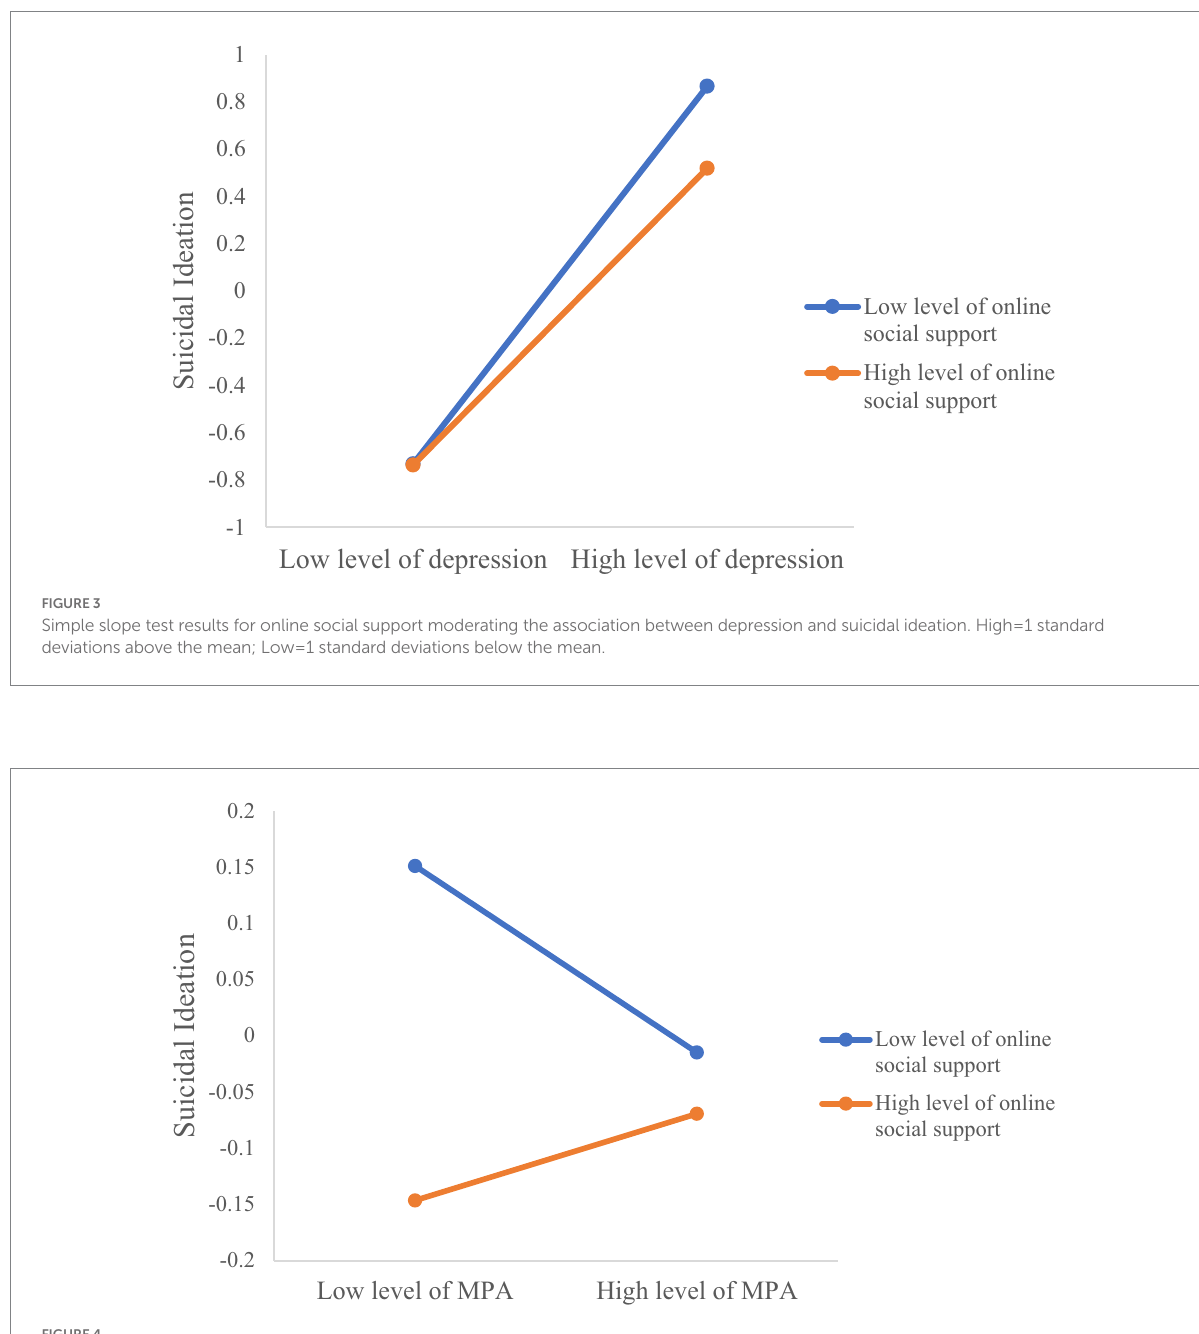
FIGURE 4 Simple slope test results for online social support moderating the association between mobile phone addiction (MPA) and suicidal ideation. High = 1 standard deviations above the mean; Low = 1 standard deviations below the